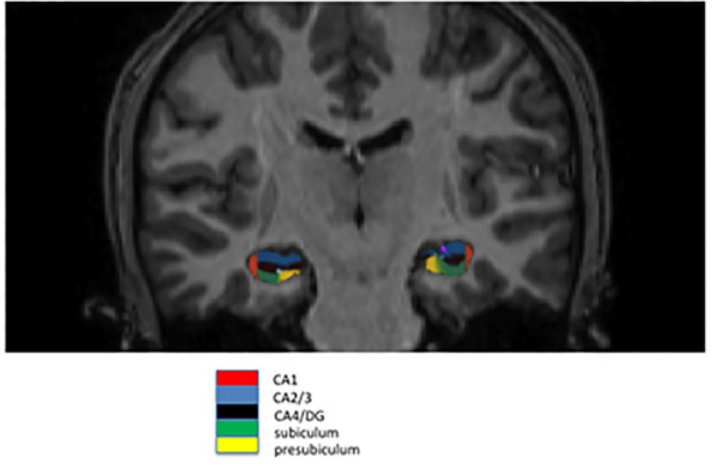
Fig 1. Example for hippocampal subfield delineation. Shown are subfields CA1, CA2/3, CA4/DG, subiculum and presubiculum. The program FreeSurfer automatically assessed volumes of subfields which were then manually viewed and checked for